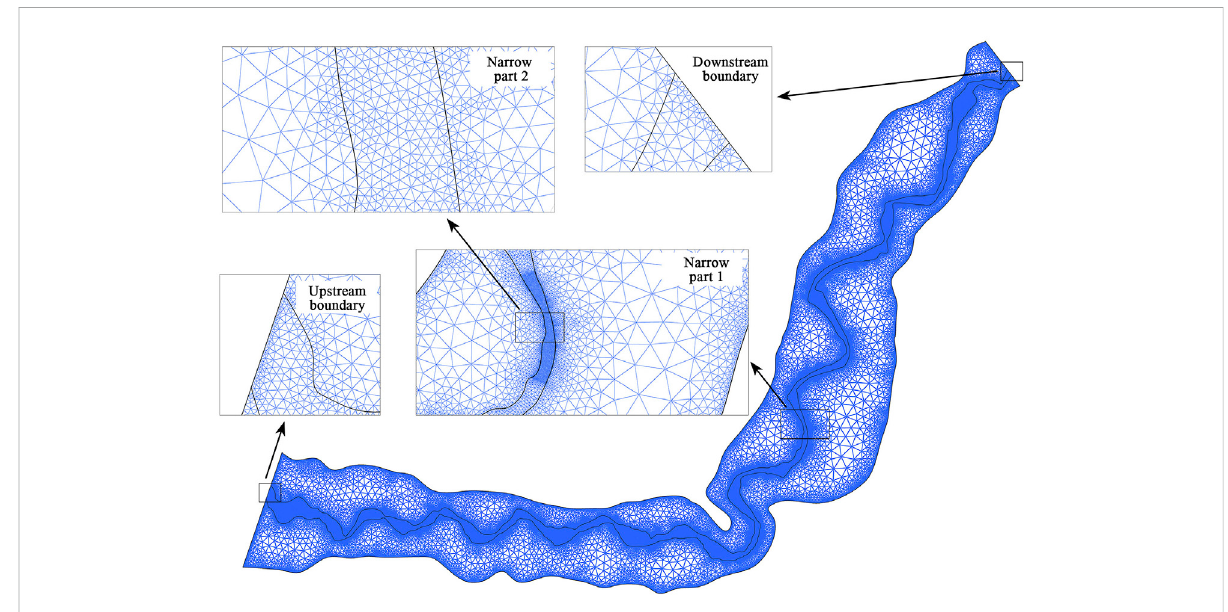
FIGURE 2 Computational grid division of the two-dimensional hydrodynamic model used in this